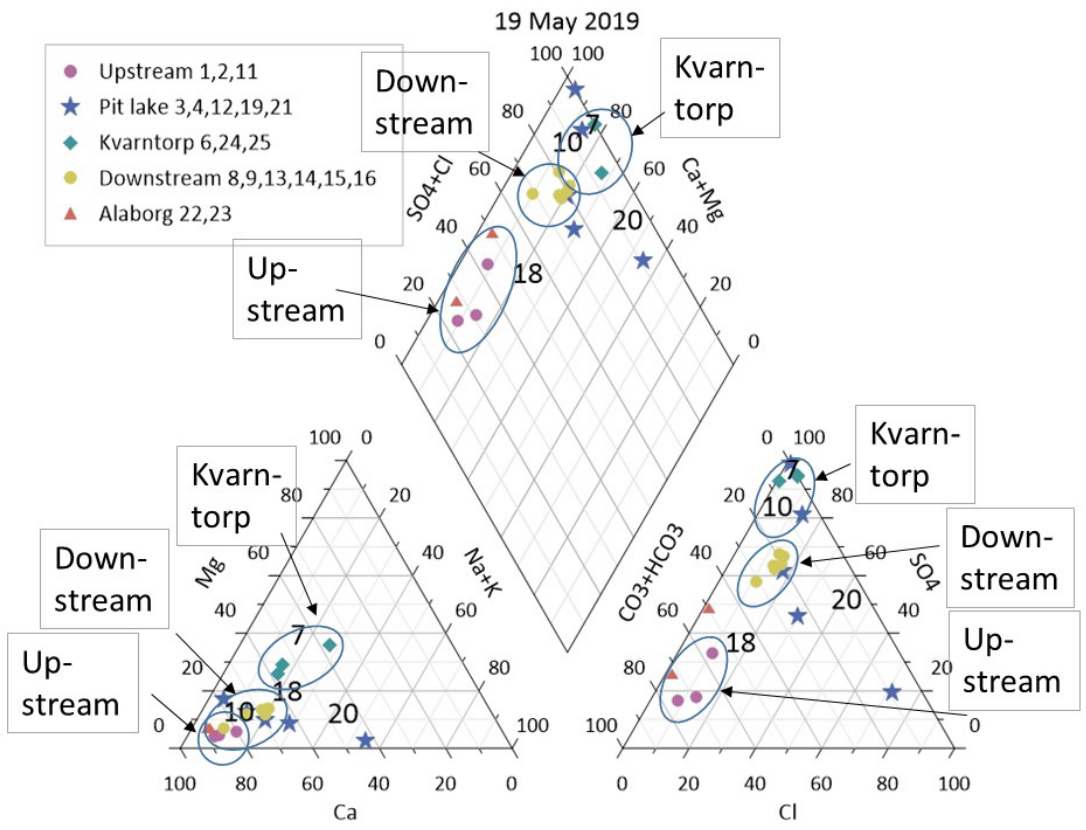
Figure 3. Piper diagram showing all localities (except 5 and 17) in the Kvarntorp area.